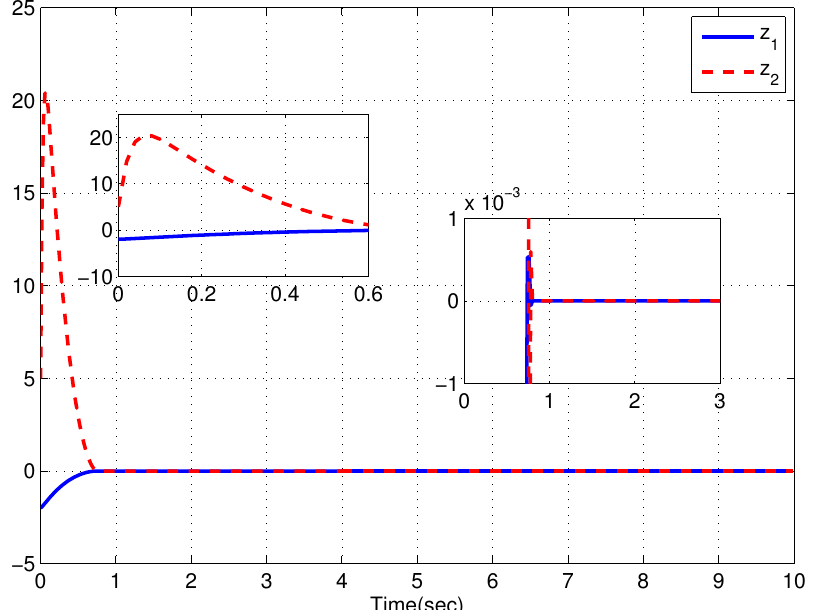
Figure 6. The state responses of the CLS with external disturbance and initial condition ( z ( 0 ) , z ( 0 )) = ( − 1,5 ) . 2 1